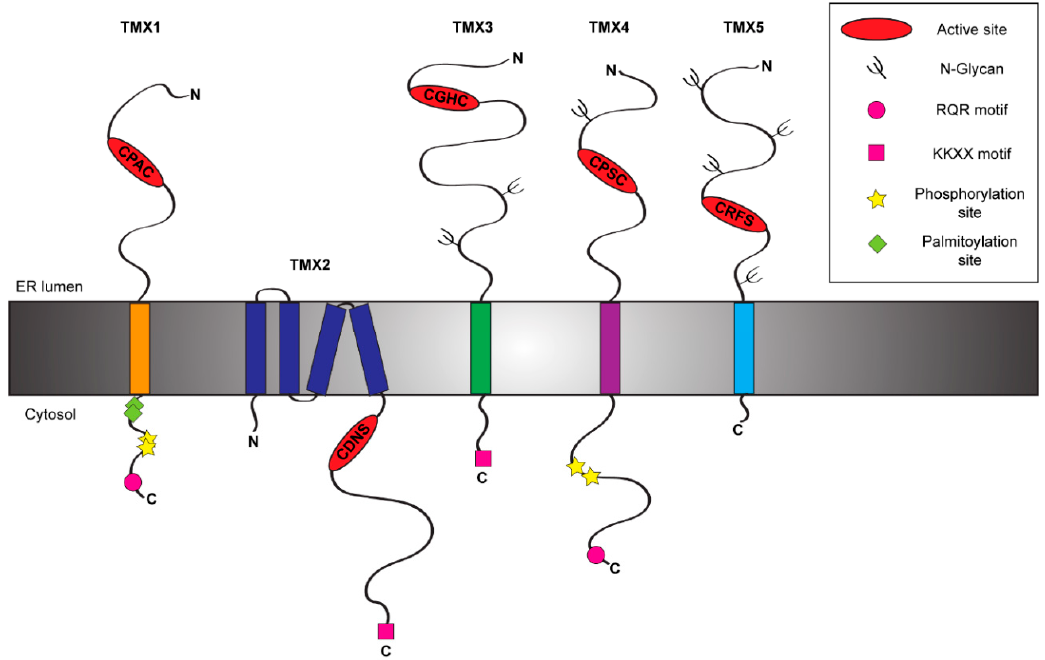
Figure 1. Schematic representation of the TMX protein family members. The figure shows the topology and the main structural and functional features of the five members of the TMX family [12– 16]. including their active site sequences and biological functions. a, active type-a TRX-like domain;